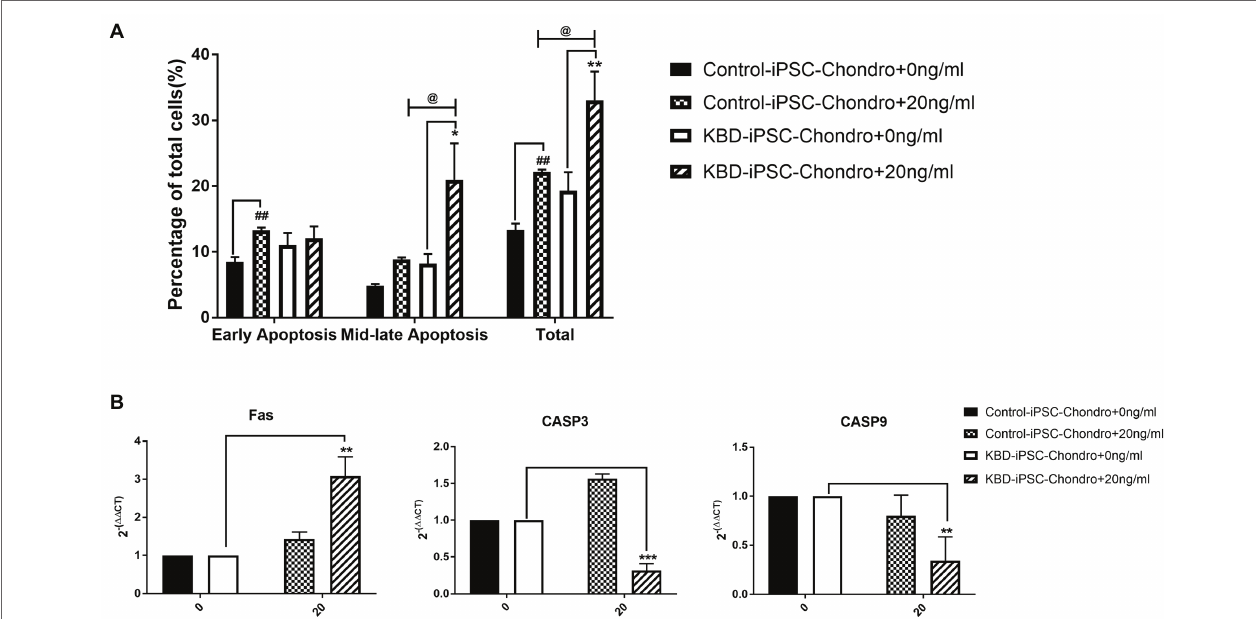
FIGURE 6 | (A) HT-2 toxin caused mid-late apoptosis in the hiPSC chondrocytes. (B) Fas was significantly upregulated in the KBD hiPSC chondrocytes after HT-2 toxin exposure; CASP3 and CASP9 were significantly downregulated in the KBD hiPSC chondrocytes. ## A significant difference between the HT-2 toxin-treated and non-treated control hiPSC chondrocytes, p < 0.01. *A significant difference between the HT-2 toxin-treated and non-treated KBD–hiPSC chondrocytes, ** p < 0.01 and *** p < 0.001. @ A significant difference between HT-2 toxin-treated control hiPSC chondrocytes and KBD hiPSC chondrocytes. hiPSCs, human induced pluripotent stem cell; KBD, Kashin–Beck